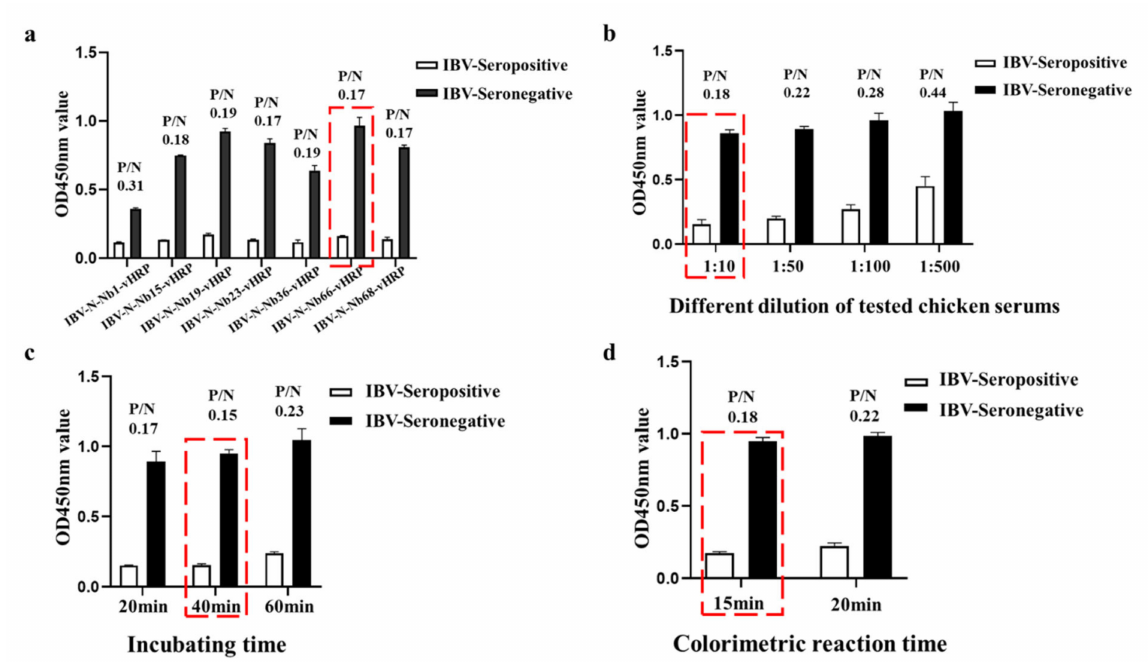
Figure 5. Optimization of the reacting conditions of the established cELISA. ( a ) Determination of the optimal blocking RANbody for developing the cELISA. ( b ) Different dilution of the tested chicken serums was detected for determination of the optimal dilution of the tested serum. ( c ) Determination of the incubation time of the cELISA. ( d ) The colorimetric reaction time was optimized. Note: (IBV-Seropositive samples ( n = 6) and IBV-Seronegative samples ( n =